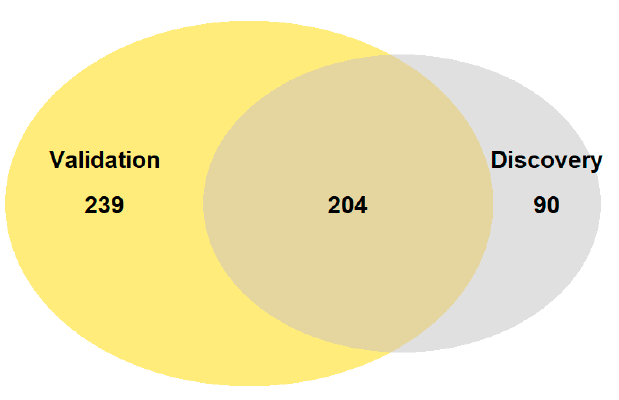
Figure 1. Overlap of significantly expressed genes of discovery and validation RNA-seq analysis. Table 3. Significant GO terms for 204 confirmed